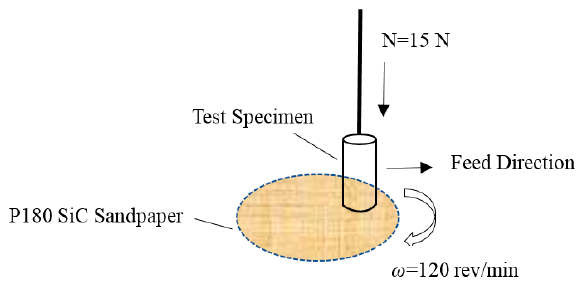
Figure 1. Schematic of wear test specimen and sandpaper.